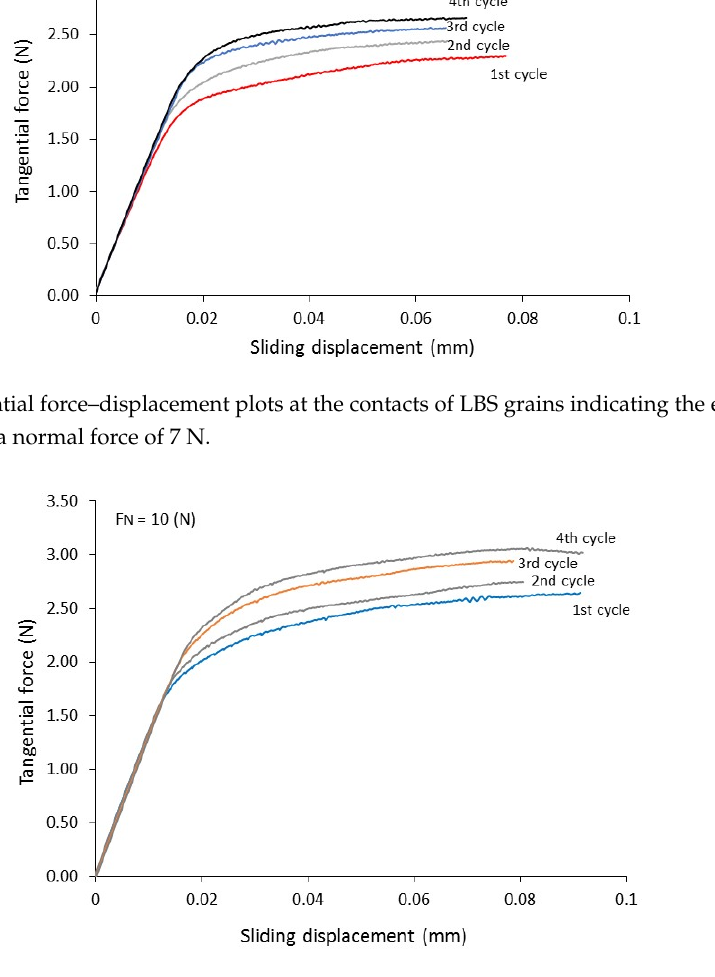
Figure 17. The effect of the shearing cycles on the inter-particle friction ratio of LBS grains. In their study, Senetakis et al. [6] quantified, for a limited number of tests, the damage to the grain surface due to shearing experiments on LBS grains. In particular, they examined the surface roughness of the grains tracking the shearing path before and after the conduction of micromechanical sliding tests. Senetakis et al. [6] reported a reduction of the surface roughness of the order of 20% to 60%, but this reduction may have been the coupled result of the application of the normal load and the shearing test. Similar observations were reported by Senetakis et al. [7] testing crushed limestone grains in their recent study. It is possible that this reduction of the surface roughness may have resulted in slightly different responses between the first and second cycle of shearing for the test at F N = 2 N. This is because the first shearing showed a peak state which was less apparent during the successive cycles, and that after the first cycle, the inter-particle friction dropped but without further notable reduction for the third and fourth shearing test. At a normal load of 1 N, it is assumed that the damage of the surface roughness might be less pronounced, which would explain the very similar shapes of the tangential force–displacement plots which were independent to the cycle number as well as the less pronounced effect of the number of shearing cycle on the inter- particle coefficient of friction. At a greater normal load of 7 or 10 N, the absence of a peak state might be explained by the possible plowing effects [9], which resulted in an increase of the inter-particle